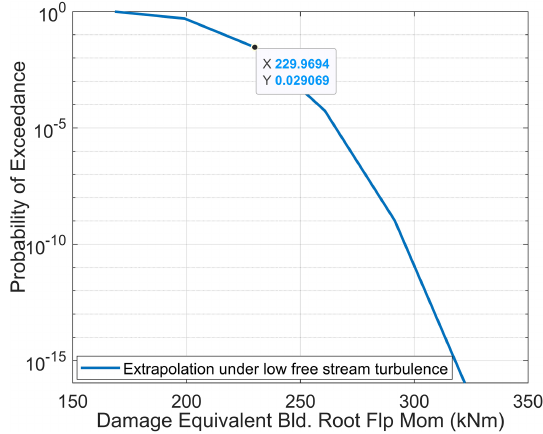
Figure 1. Blade root flap damage equivalent moment extrapolation at 10ms − 1 for low wind